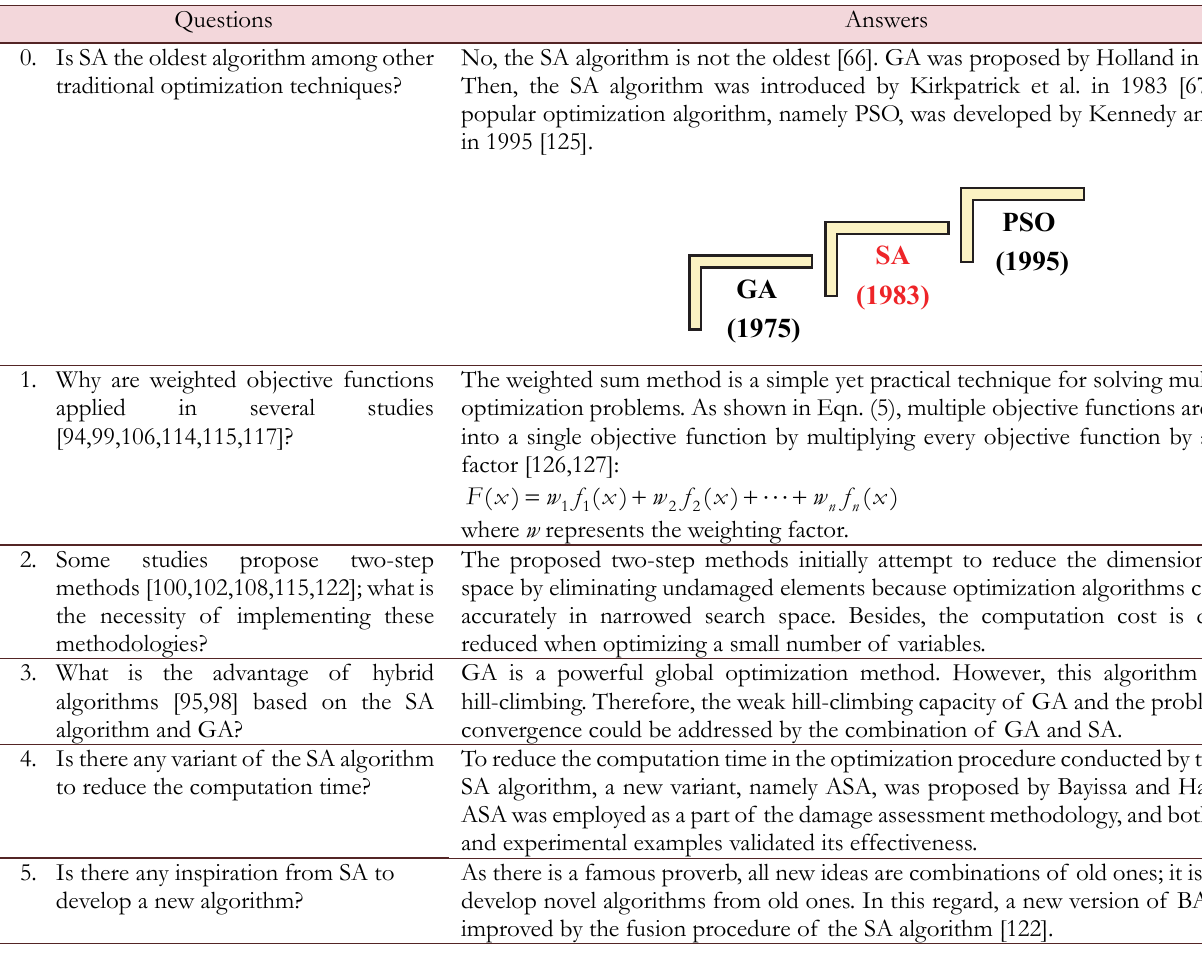
Table 3: Several questions and answers to make a discussion on the application of SA in